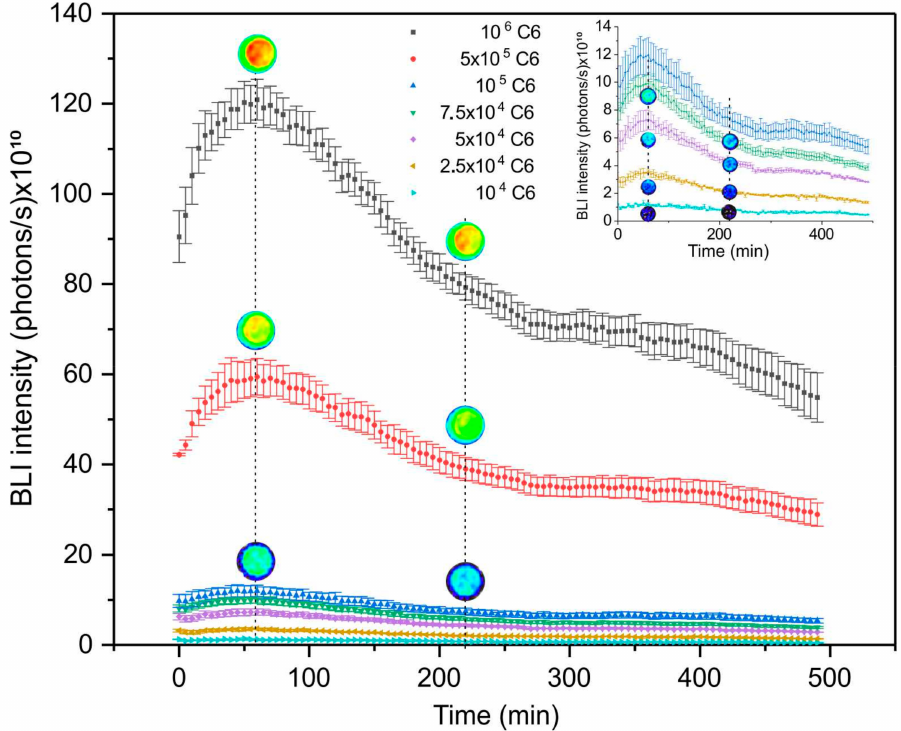
Figure 2. Bioluminescence kinetics signal as a function of C6 transduced with luciferase concentrations. The inset figure shows the curve amplification for lower cellular concentrations analysed for the variance between